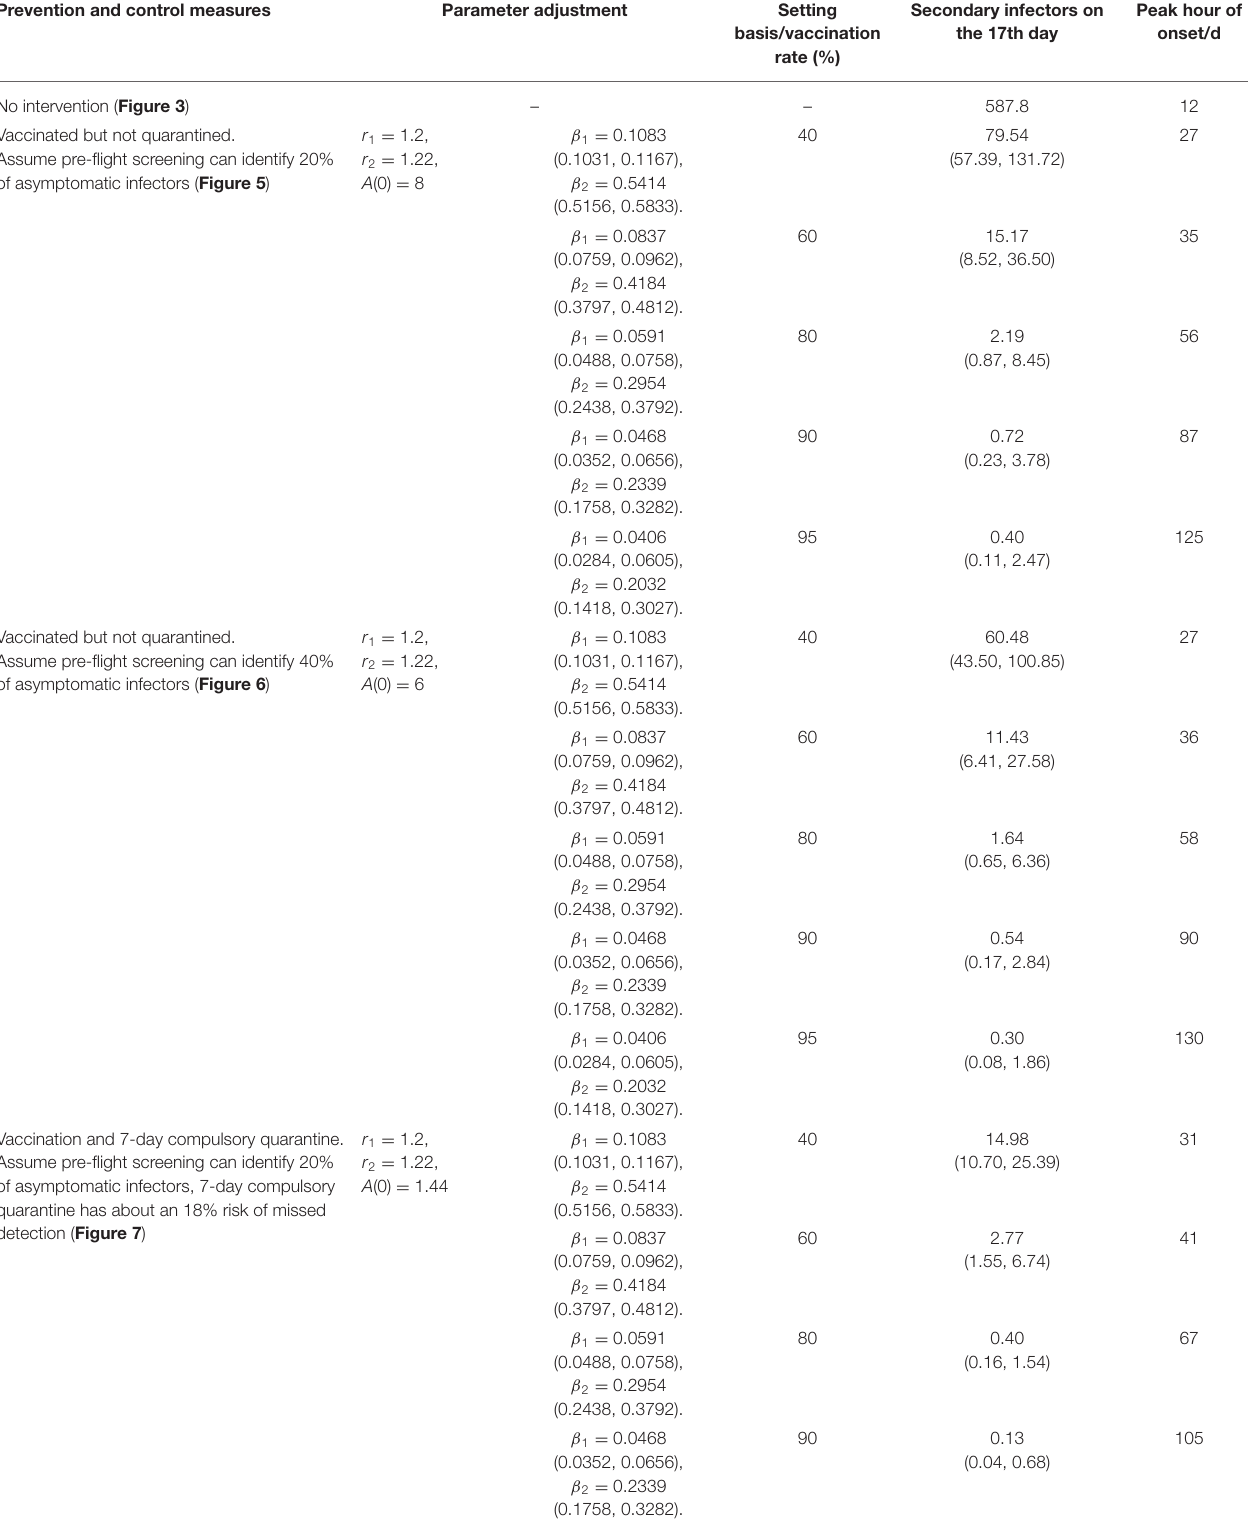
TABLE 5 | Parameter adjustment and transmission after